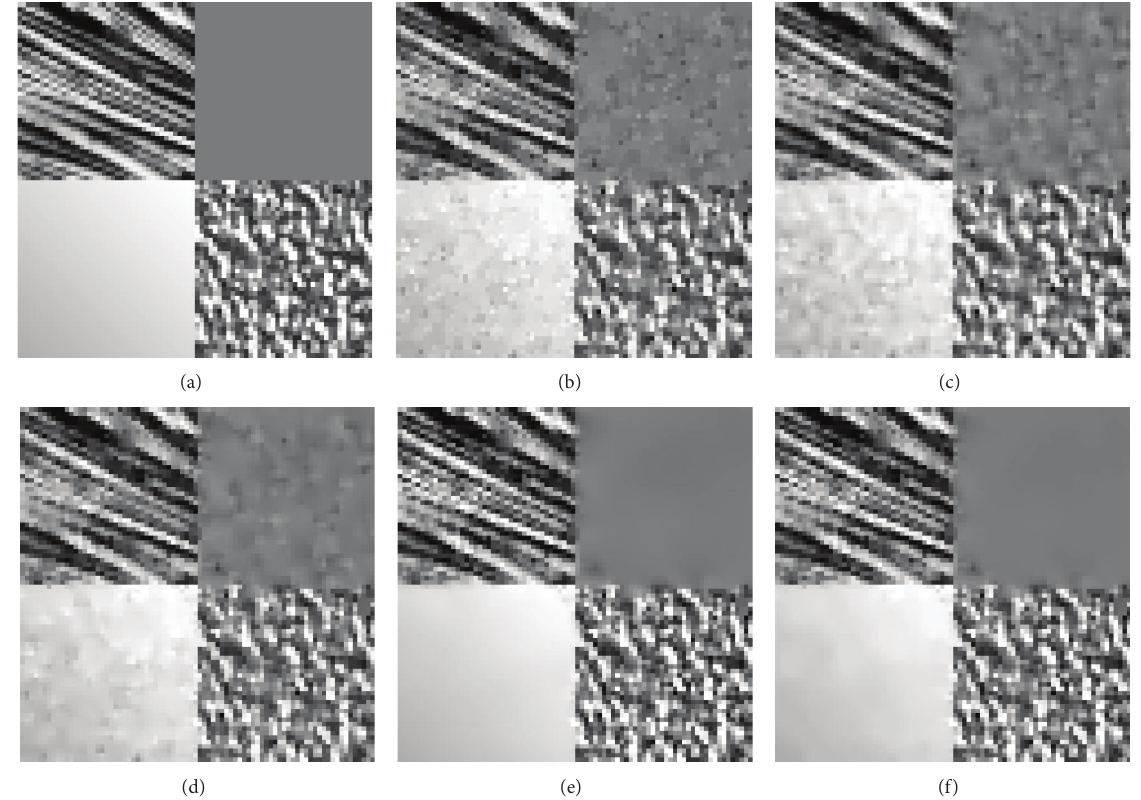
Figure 7: Zoomed-in local results corresponding to Figures 4(b)–4(f): (a) the original image, results of (b) the ROF model, (c) the LLT model, (d) the hybrid model, (e) our Model 1, and (f) our Model